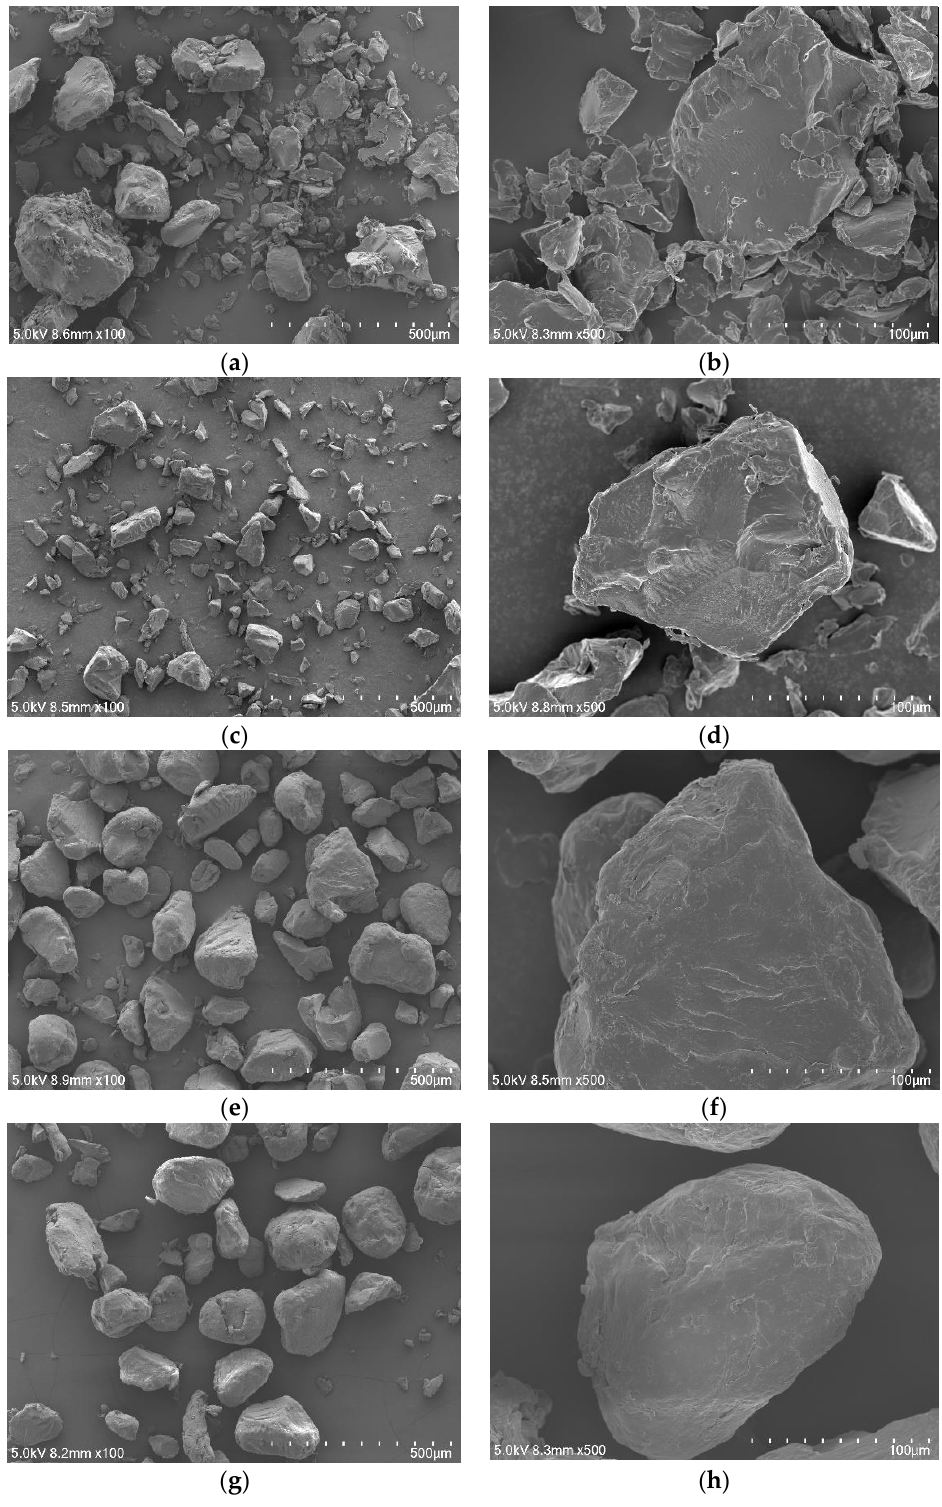
Figure 5. SEM images of microplastics before and after alkali digestion at 100× and 500×: ( a , b ) un- digested PA6; ( c , d ) digested PA6; ( e , f ) undigested PA66; ( g , h ) digested